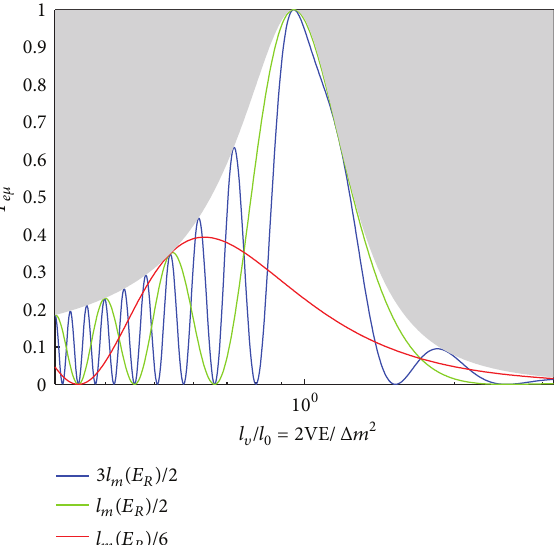
Figure 6: Resonance enhancement of neutrino oscillations in matter with constant density. Shown is the dependence of the transition probability ] 𝑒 → ] 𝜇 on energy for sin 2 𝜃 13 = 0.0241 for three different sizes of layers: 𝐿 = 3𝑙 𝑚 (𝐸 𝑅 )/2 , 𝑙 𝑚 (𝐸 𝑅 )/2 , and 𝑙 𝑚 (𝐸 𝑅 )/6 . The shaded area shows the resonance envelope: sin 2 2𝜃 𝑚 (𝐸)